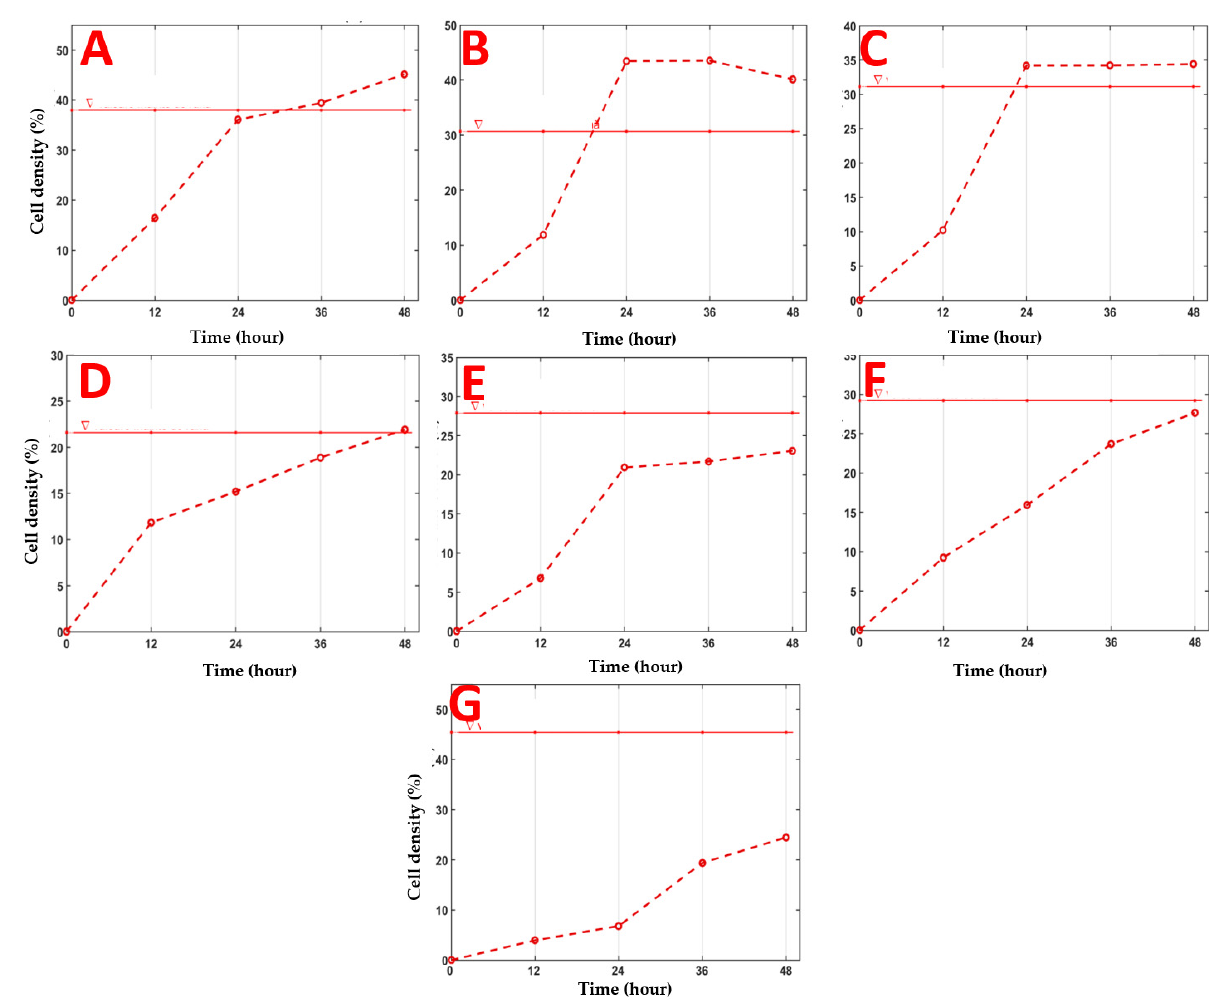
Figure 5. The evolution of the cell density parameter inside the wound depending on the applied treatment and time. The horizontal red line represents the initial density of the cells before the application of the “scratch” test, and the dotted red line represents the evolution in time of the cell density (%) depending on the applied treatment. Stellaria media (L.) Vill extract was applied in concentrations of: 200 µ g/mL ( A ), 100 µ g/mL ( B ), 50 µ g/mL ( C ), 25 µ g/mL ( D ), 12.5 µ g/mL ( E ), Positive Control (CTRL), 50 µ g/mL Allantoin ( F ), and control (CTRL0) ( G ), without any